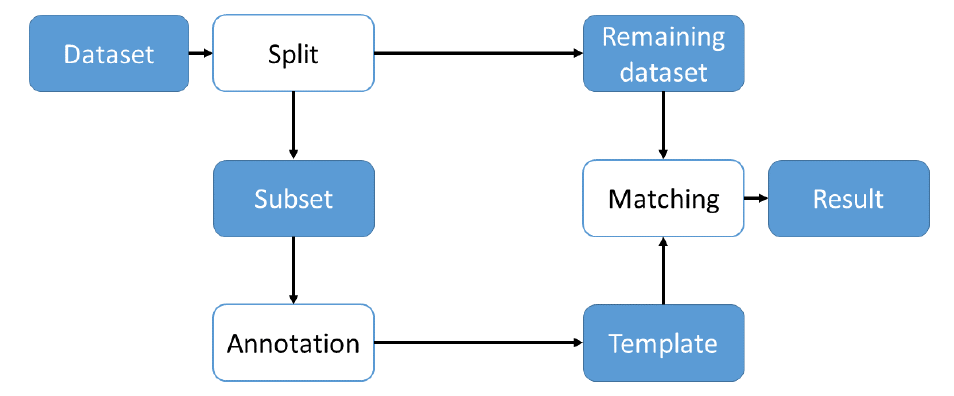
Figure 3. Basic approach for finding matches in a dataset. Blue boxes represent data, white boxes the processing of